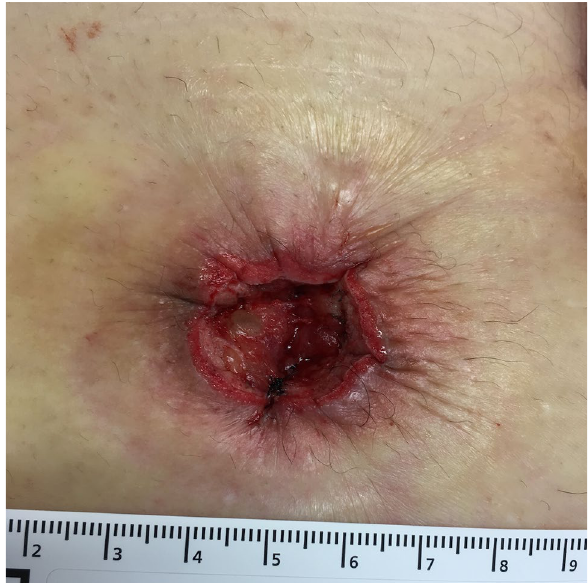
Figure 2. The granulation had grown to the extent that the abdominal rectus muscle fascia and the suture was covered. There was no obstruction of blood flow in the granulation. NPWTi-d therapy was finished.